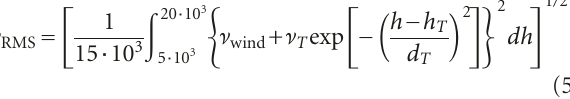
core diameter of 10 μ m a core refractive index of 1.46, and a core/cladding refractive indices di ff erence of 0.3%. As ex- small perturbations, but drops dramatically to very small val- munication links (i.e., with h HAP > 17km and D < 20cm), the mean coupling loss is always less than 1.2 dB, while for communication links to a ground station it significantly in- creases to values larger than 7 dB.